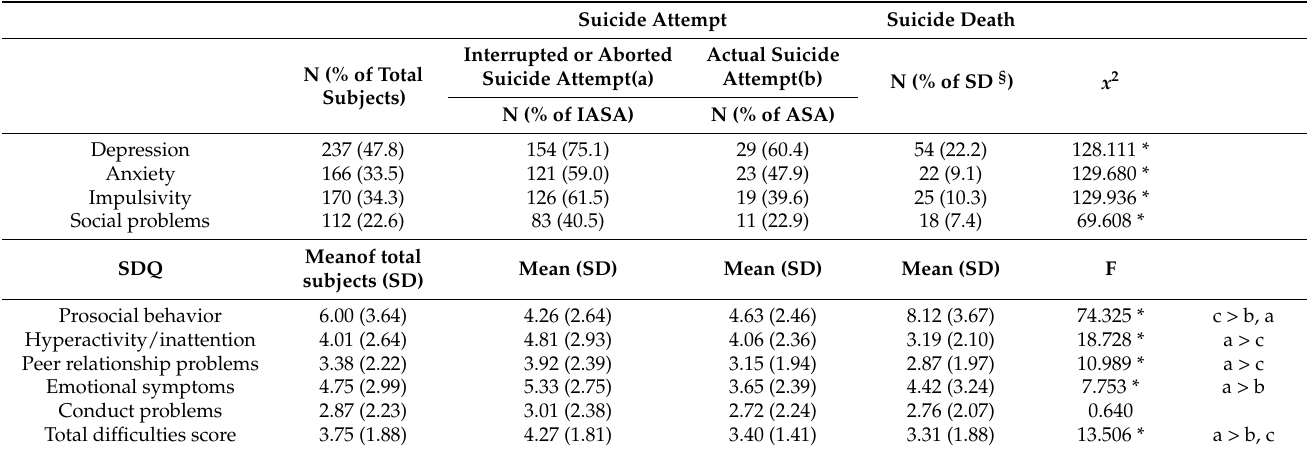
Table 2. Comparison of emotional and behavioral status.